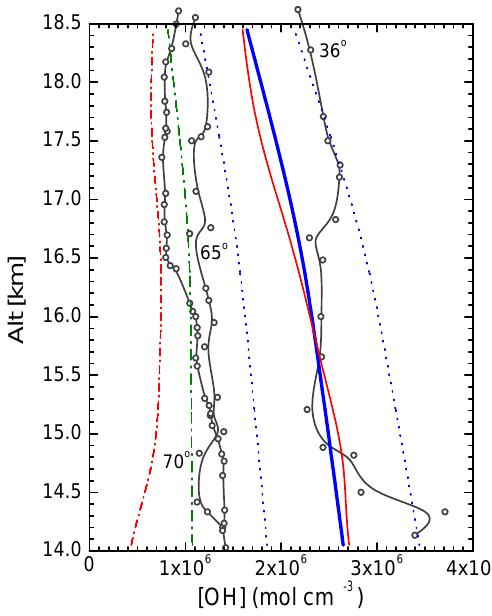
Fig. 6. Optimum OH concentrations to produce the best matches of the mixing ratio simulation to the observations are plotted against altitude, denoted by blue solid line. The base profile is the OH es- timate from the GMI run (green dash-dotted line). The two blue dotted lines denote uncertainty range for ± 30% of the [OH]. The optimization process was tested by repeating the analysis with the OH profile derived from Geos-Chem model run; base and resulting profiles are given in red dash-dotted line and red solid line, respec- tively. For comparison, the observed OH concentrations (Wennberg et al., 1995, 1998) are plotted as gray line and empty symbols, re- spectively. Shown is the solar zenith angle (SZA) of each observa- tion